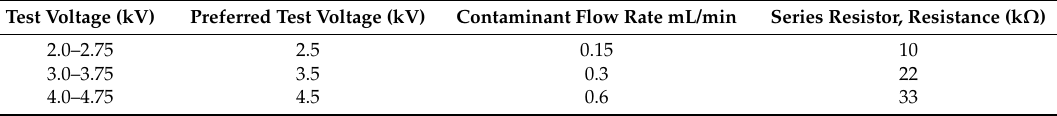
Figure 1. Schematic diagram of inclined plane test. The silicone rubber sample was fixed onto an inclined plane by two electrodes and contaminated liquid was dropped to the sample via filter paper. Table 2. Configuration of the inclined plane test for different testing levels.